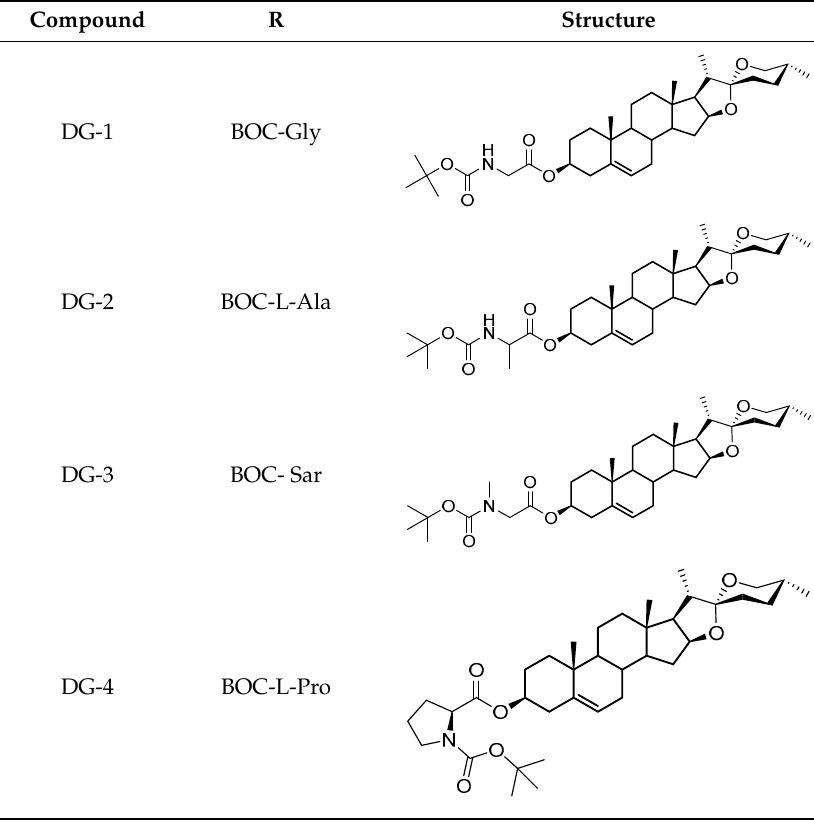
Table 1. The structures of diosgenin-amino acids derivatives DG-1 to 18.